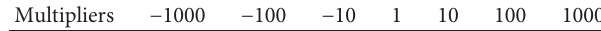
Figure 8: System 1: dropped TTI ratio for each interrupt coalescing timeout tested. The red line is the median with the vertical bars depicting ± one standard deviation. 5 MHz bandwidth. Table 4: Initial value multipliers used in generating initial values for least squares curve